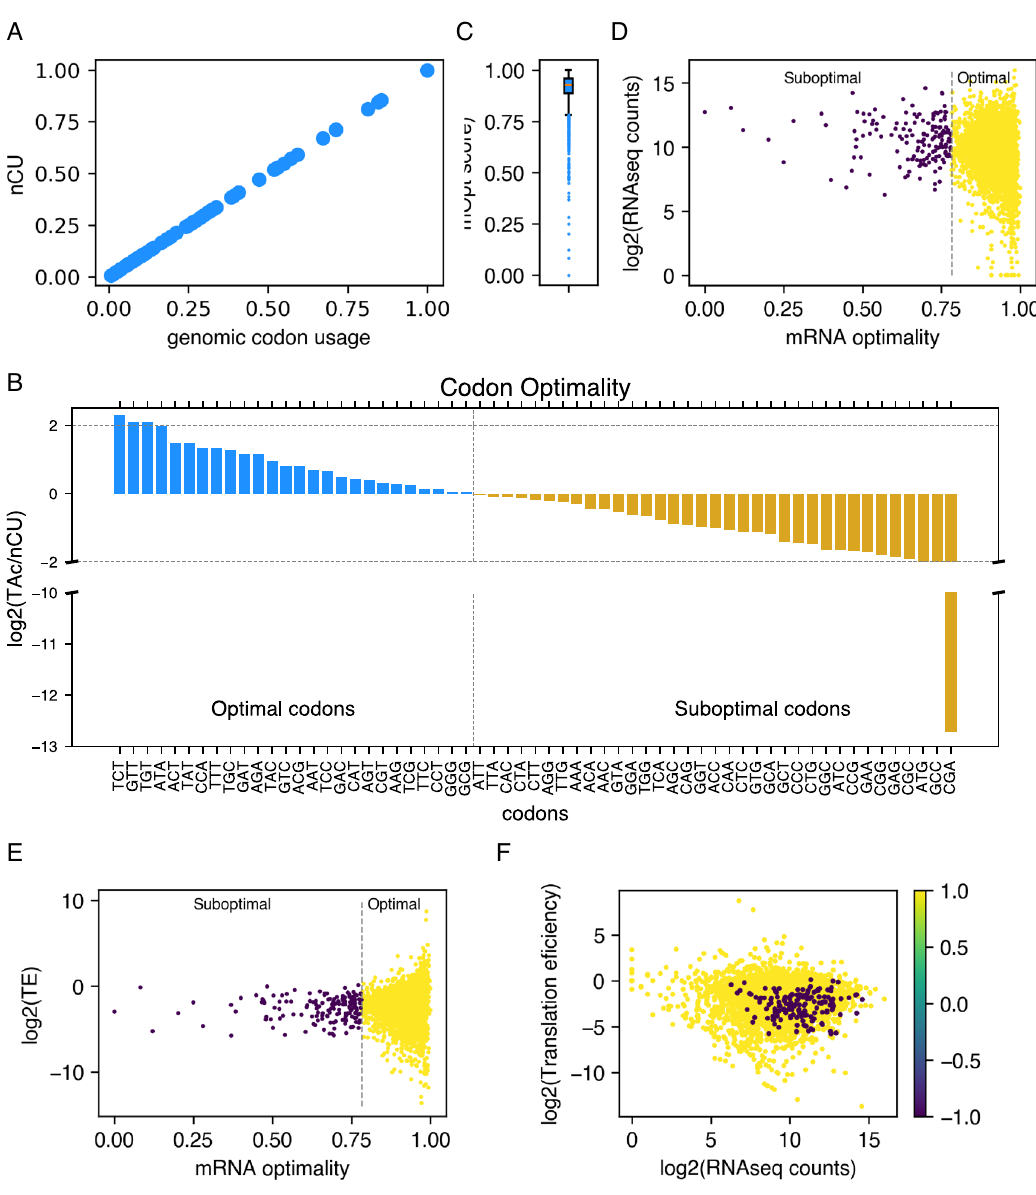
Figure 5. mRNA adaptability does not correlate with translation efficiency. ( A ) A scatterplot comparing nCU with genomic codon usage. ( B ) A bar plot showing the codon adaptability (cOpt) values . The golden coloured bars indicate suboptimal codons and blue bars indicate optimal codons. ( C ) A box plot showing the distribution of mRNA optimality values (mOpt). The blue dots below the bottom whisker indicate the outliers. ( D , E ) A scatterplot comparing the mOpt values with mRNA abundance ( D ) and translation efficiency ( E ). ( F ) A scatterplot comparing the translation efficiency and mRNA abundance with the suboptimal mRNAs identified in purple